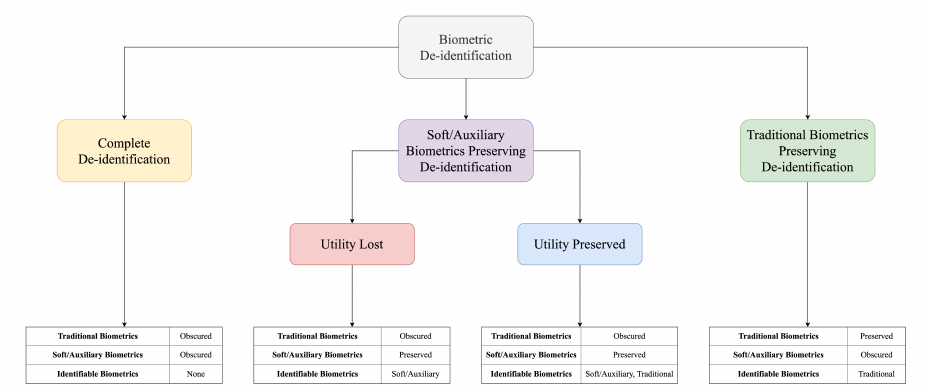
Figure 1. Taxonomy of biometric